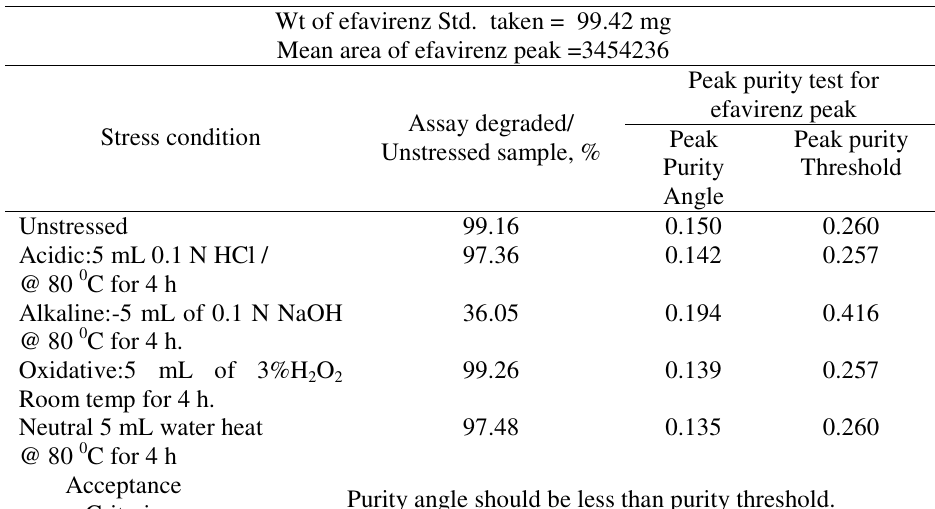
Table 1. Forced degradation study for efavirenz